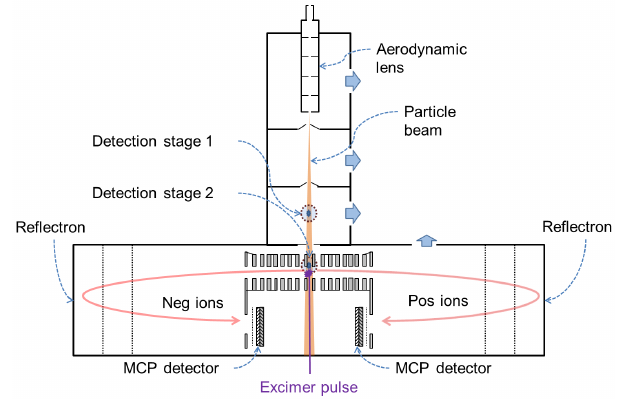
Figure 1. Schematic diagram of the LAAP-TOF